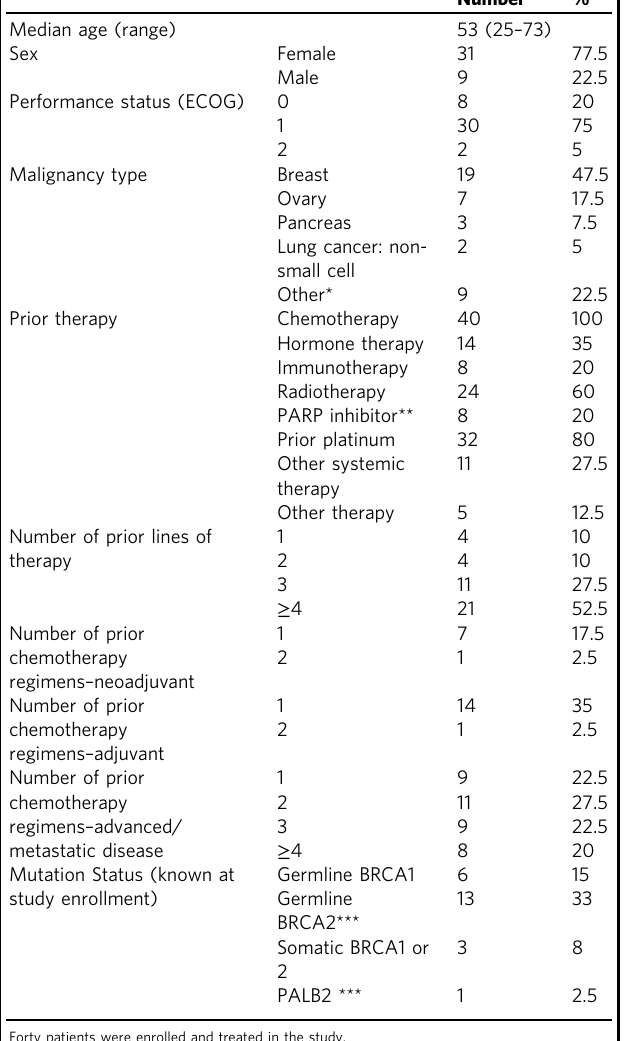
Table 1 Patient